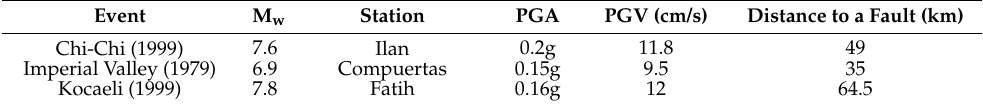
Table 5. Far-fault earthquake time